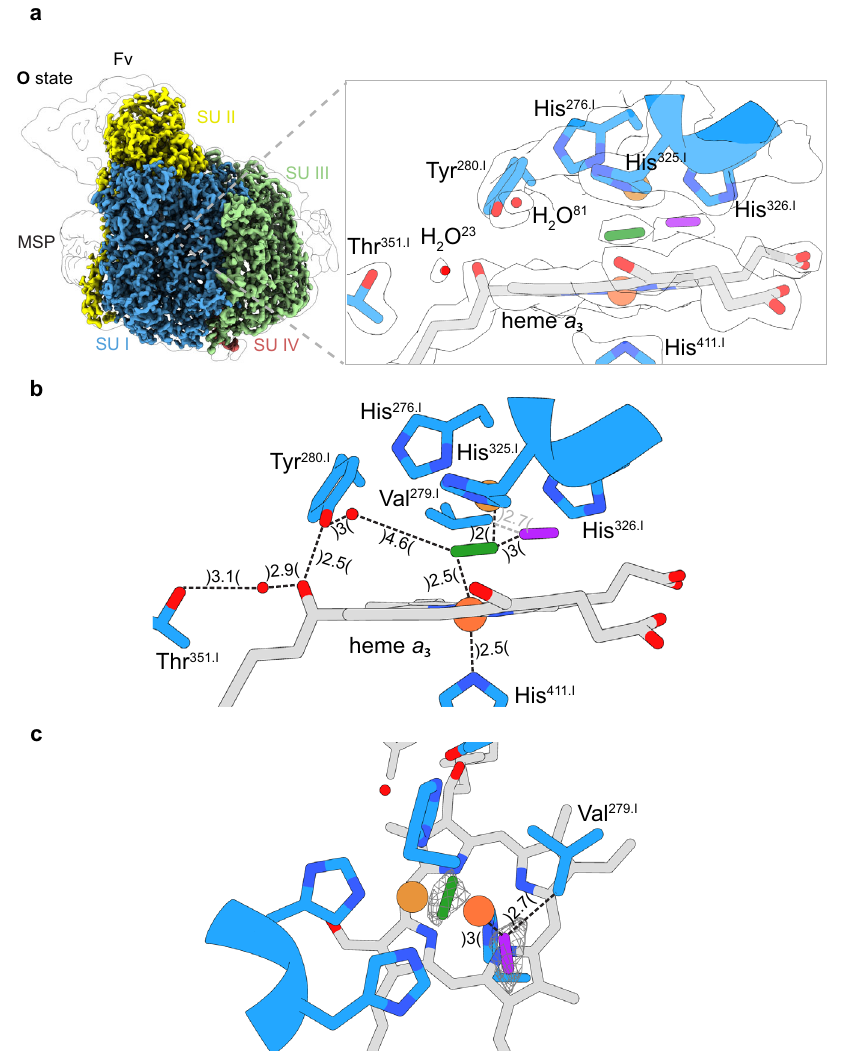
Fig. 4 Cryo-EM density map (O-state) and modelled structure of the binuclear site in C c O. a Structural overview of the binuclear site in the O -state. The bridging peroxide species (green) is located in-between the iron (orange) and the copper (brown) atom. In close proximity to the observed bridging ligand, a second prominent density presumably molecular oxygen (purple), is located. b Measured distances (Å) for the modelled molecules at the active site. c Top view of the active site. The corresponding density map is illustrated as a white surface or mesh volumes. The illustrated map densities are fi ltered to equal contour levels